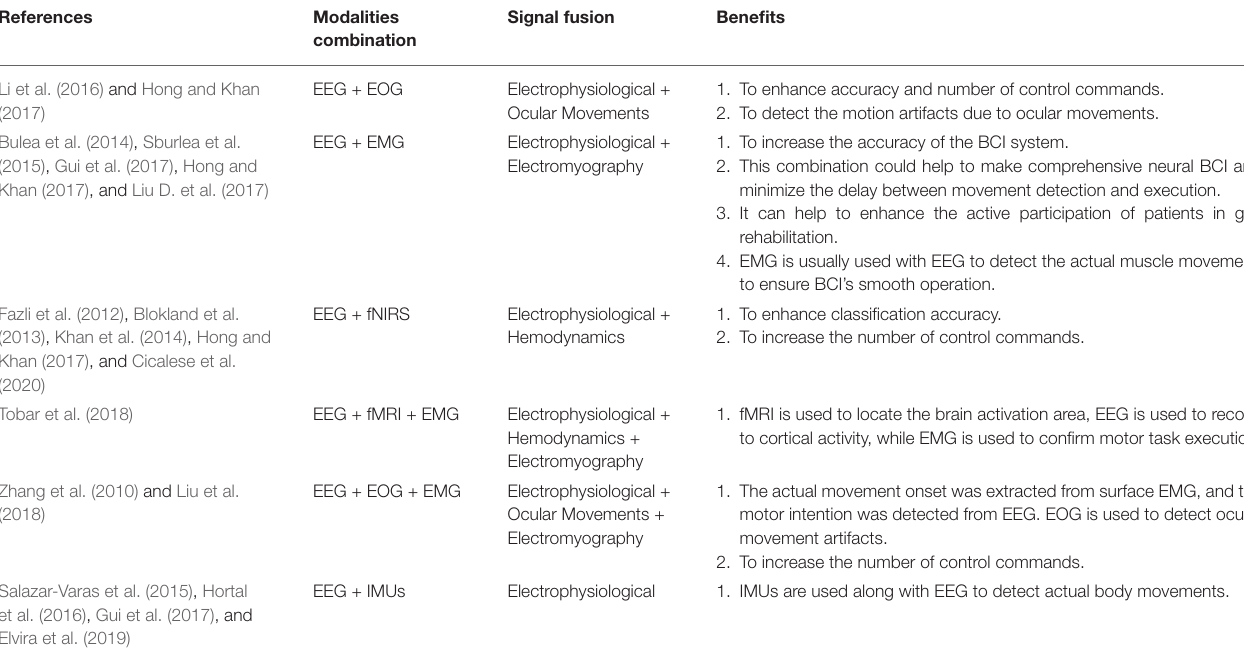
TABLE 1 | Combination of the brain and non-brain signals modalities.